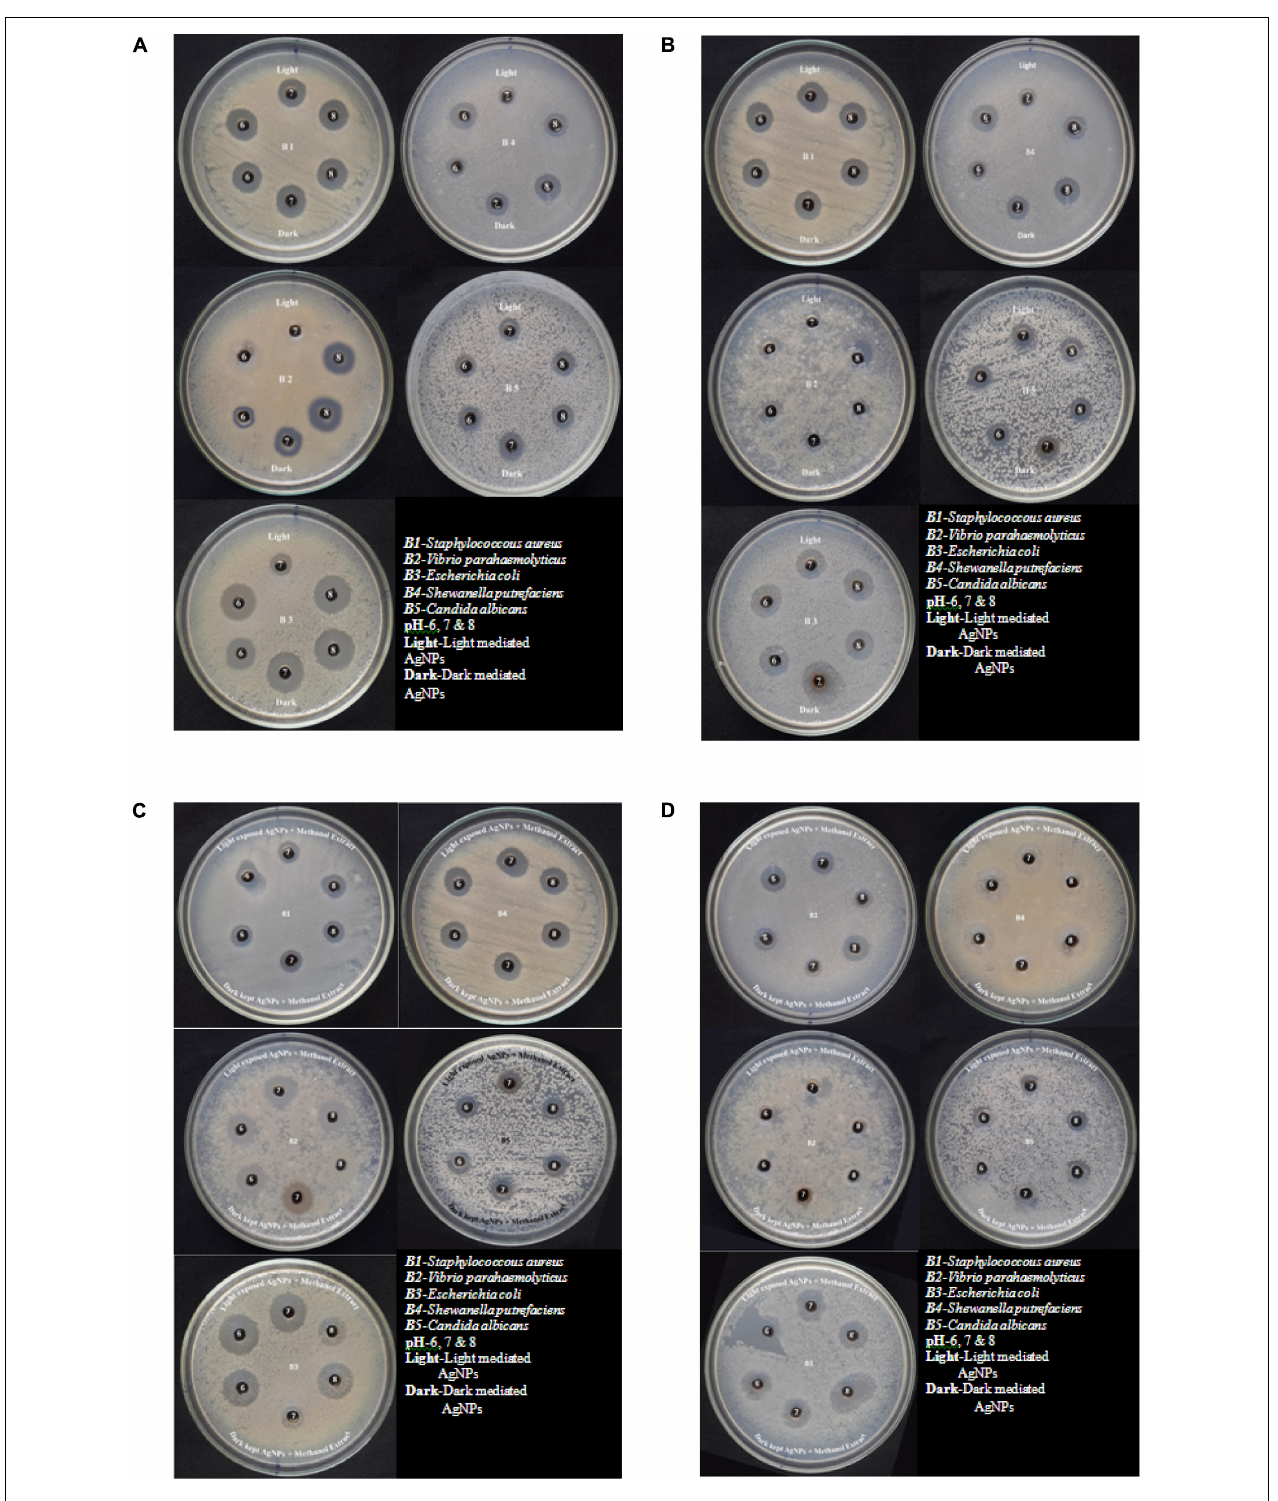
FIGURE 5 | (A) Antimicrobial effect of light-mediated AgNPs synthesized from culture filtrate of P. variotii . (B) Antimicrobial effect of light-mediated AgNPs synthesized from aqueous filtrate of P. variotii . (C) Antimicrobial effect of light-mediated AgNPs synthesized from methanol extracted culture filtrate of P. variotii . (D) Antimicrobial effect of light-mediated AgNPs synthesized from methanol extracted aqueous filtrate of P. variotii .